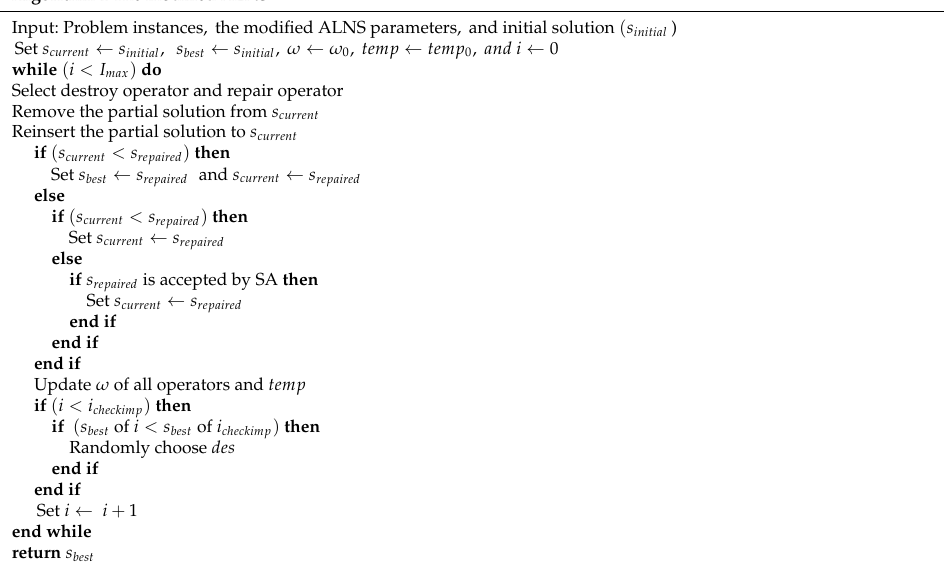
Figure 2. Flowchart of the proposed two-stage ALNS. Algorithm 1 The modified